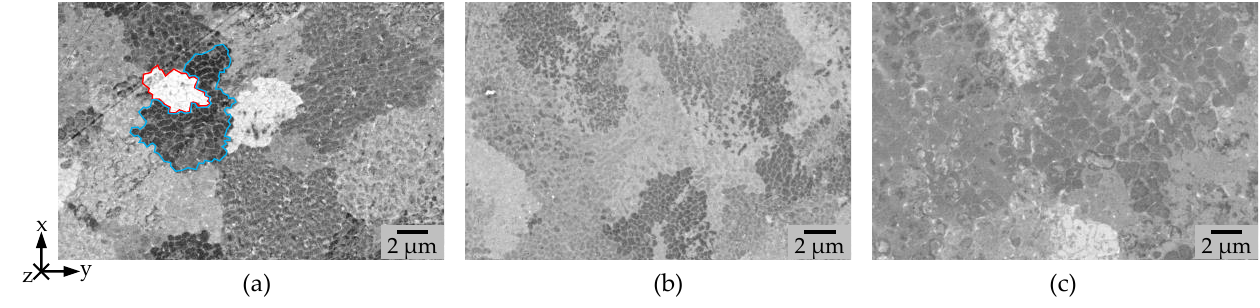
Figure 5. Temperature measured below the built plate and estimated surface temperature.